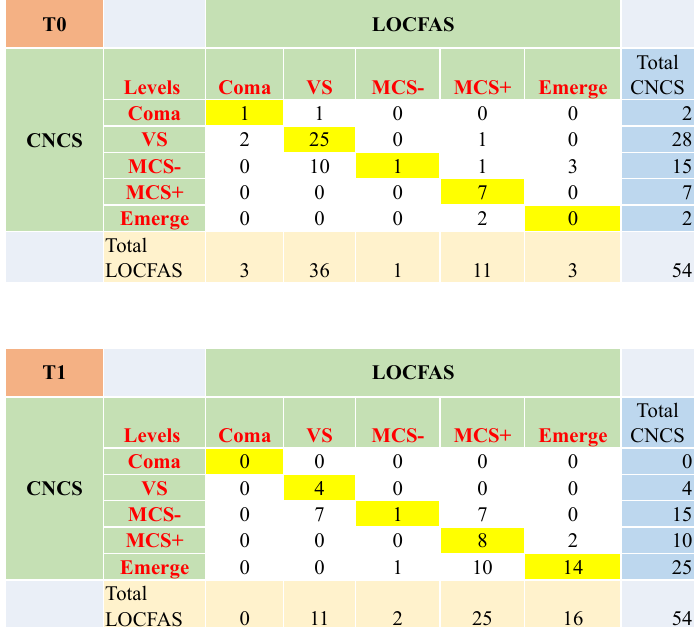
Figure 4. Clinical agreement between CNCS and LOCFAS at T0 and T1 for patients aged older than 48 months. At T0, agreement was 63.0% (yellow boxes, Cohen-Kappa = 0.40), and 50% at T1 (Cohen-Kappa = 0.33). VS: vegetative state.